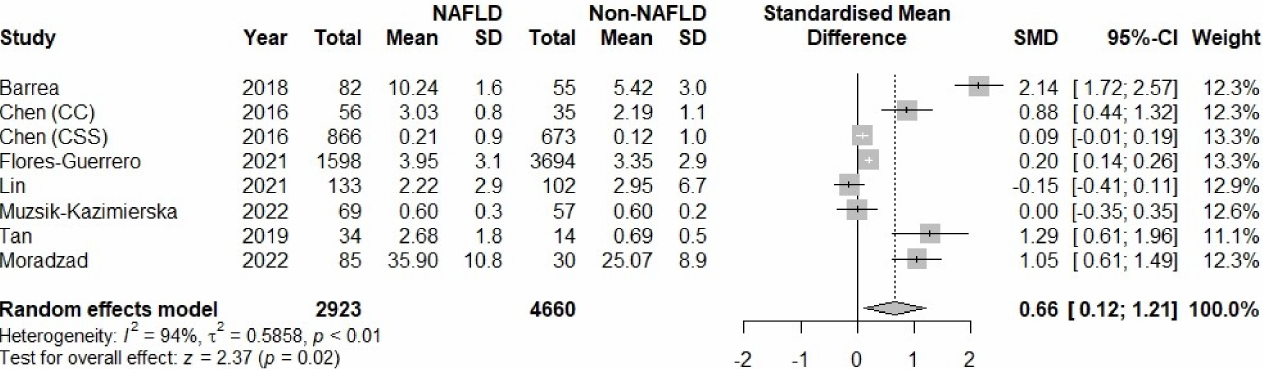
Figure 2. Forest plot displaying the meta-analysis of circulating trimethylamine N-oxide (TMAO) difference between individuals with and without non-alcoholic fatty liver disease (NAFLD), demon- strating significantly higher TMAO levels in the NAFLD group. Effect sizes were pooled according to the random-effects model. I 2 was used as a measure of between-study statistical heterogeneity. Results are expressed as standardized mean difference (SMD) with horizontal error bars denoting the 95% confidence intervals (CIs). The size of each square represents the relative weight of that study in the overall meta-analytic